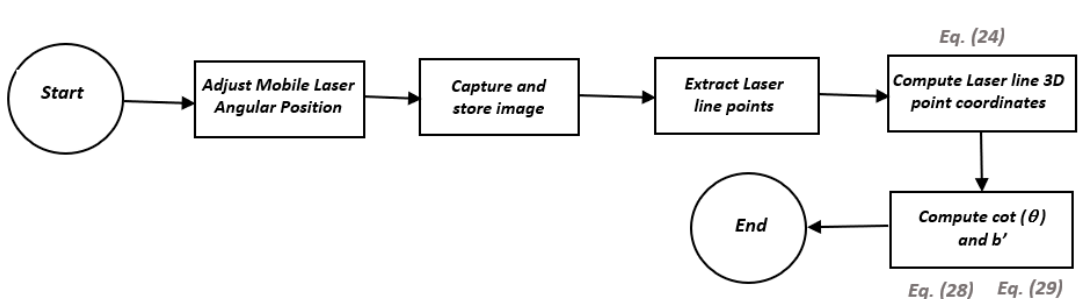
Figure 11. Fixed laser calibration algorithm.